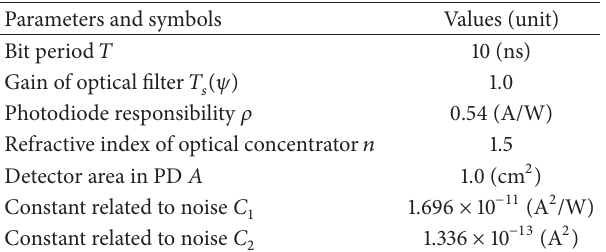
Figure 2: Propagation link with first reflection of a VLC system. Table 2: System